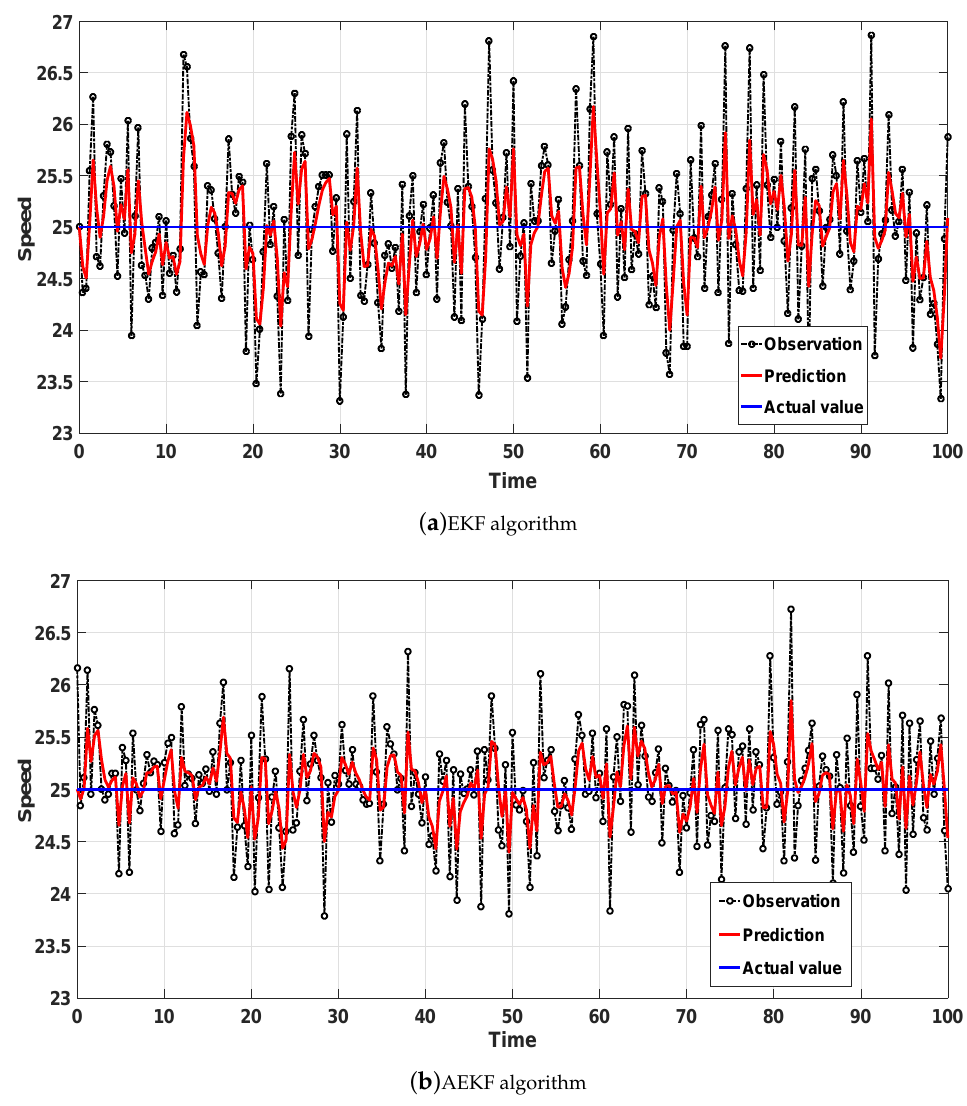
Figure 7. Speed prediction effect in the constant speed